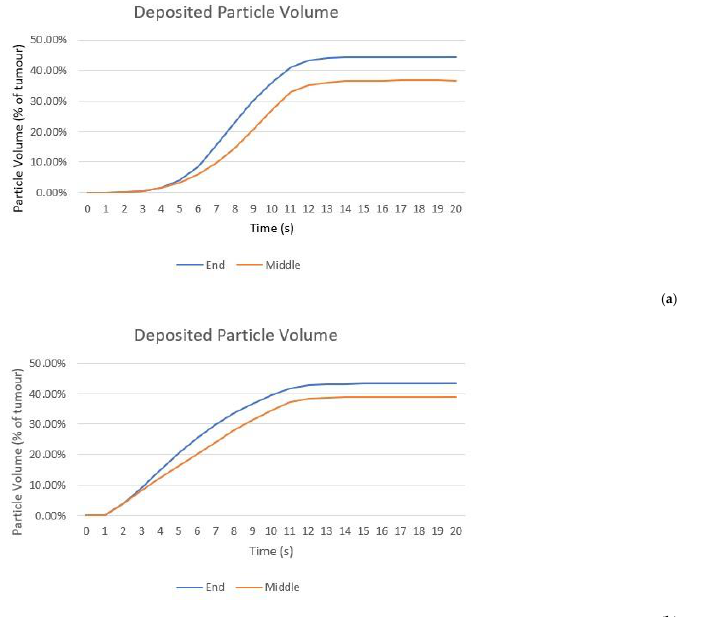
Figure 10. Change in the calculated volume of ( a ) negatively charged; ( b ) positively charged particles as a percentage of total tumour volume deposited onto cell surfaces from the start of injection to 10 s post-injection for two different injection locations, threshold 1 × 10 −7 mol/m 2 .